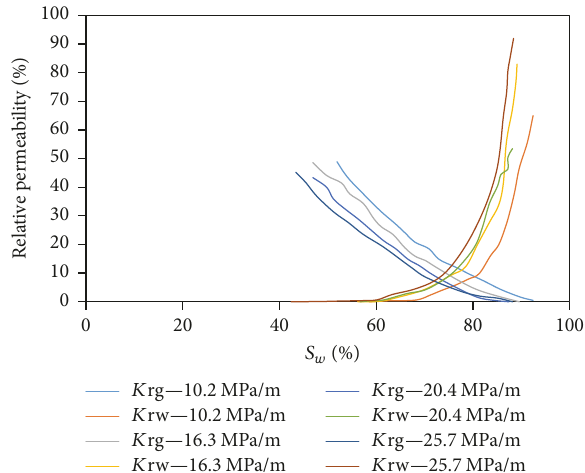
Figure 3: Gas-water relative permeability under different draw- down pressure